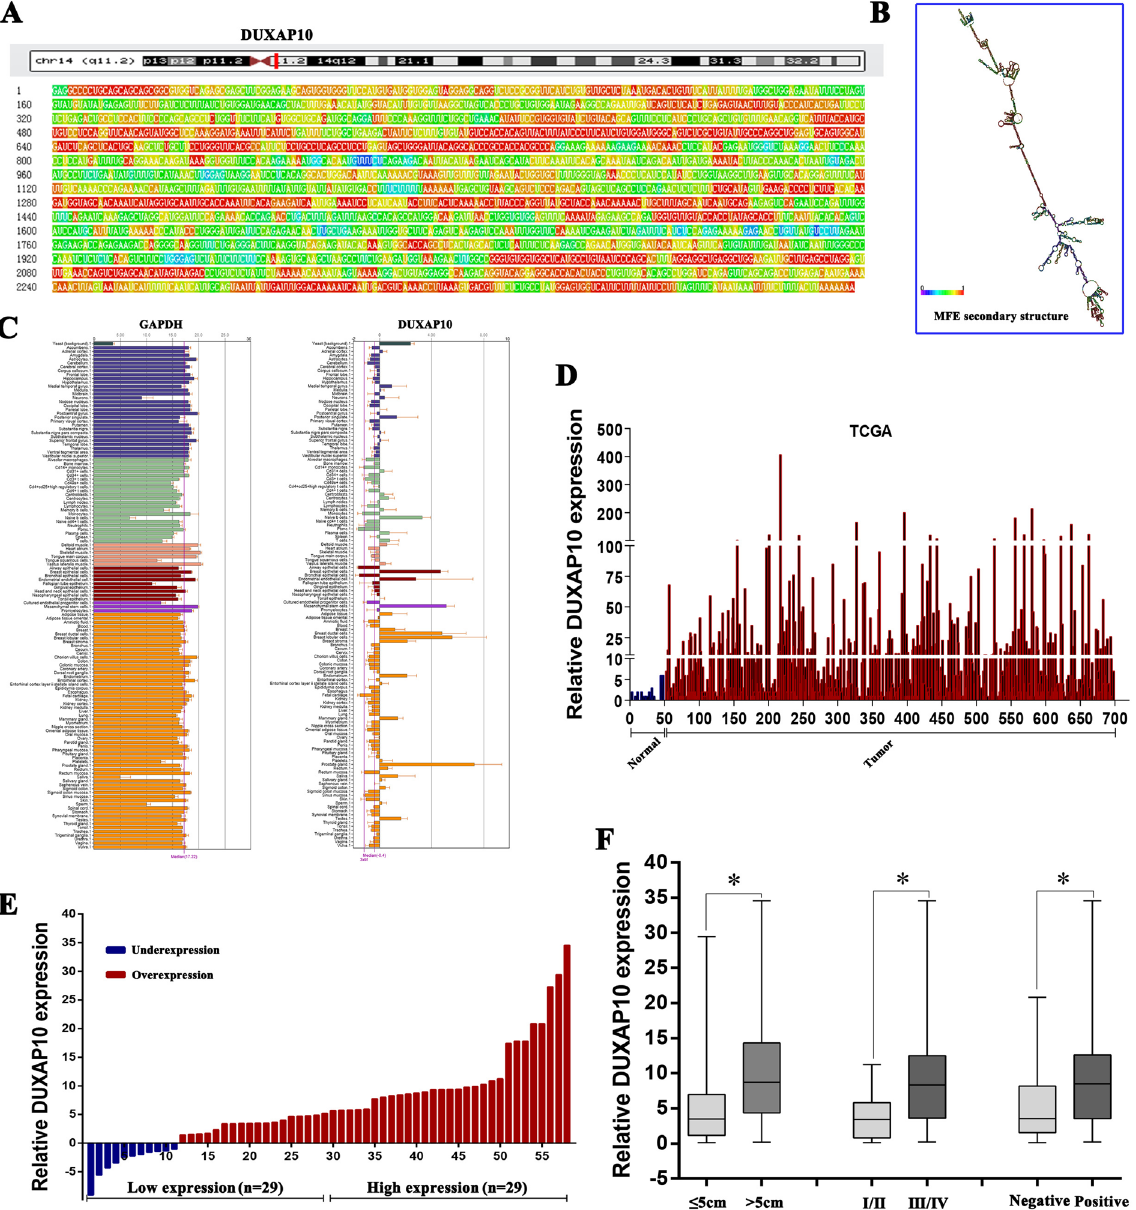
Figure 1. Relative DUXAP10 expression in CRC tissues and its clinical significance. ( A ) The full sequence of DUXAP10 is published in the NCBI database (NR_110526.1). ( B ) Prediction of DUXAP10 structure based on minimum free energy (MFE) and partition function. Color scale indicates the confidence for the prediction for each base with shades of red indicating strong confidence. (http://rna.tbi.univie.ac.at/). ( C ) Low DUXAP10 expression levels in normal human colorectal tissues. The protein coding gene GAPDH was used as a control. ( D ) Relative expression of DUXAP10 in colorectal cancer tissues compared with normal tissue was analyzed by using TCGA data. ( E ) Relative expression of DUXAP10 in CRC tissues compared with corresponding adjacent normal tissues (n = 58), and DUXAP10 expression was classifid into two groups. (F) DUXAP10 expression was significantly higher in patients with a larger tumor size, a higher pathological stage and lymph node metastasis (shown as Δ CT). Bars: s.d., * P < 0.05, ** P <